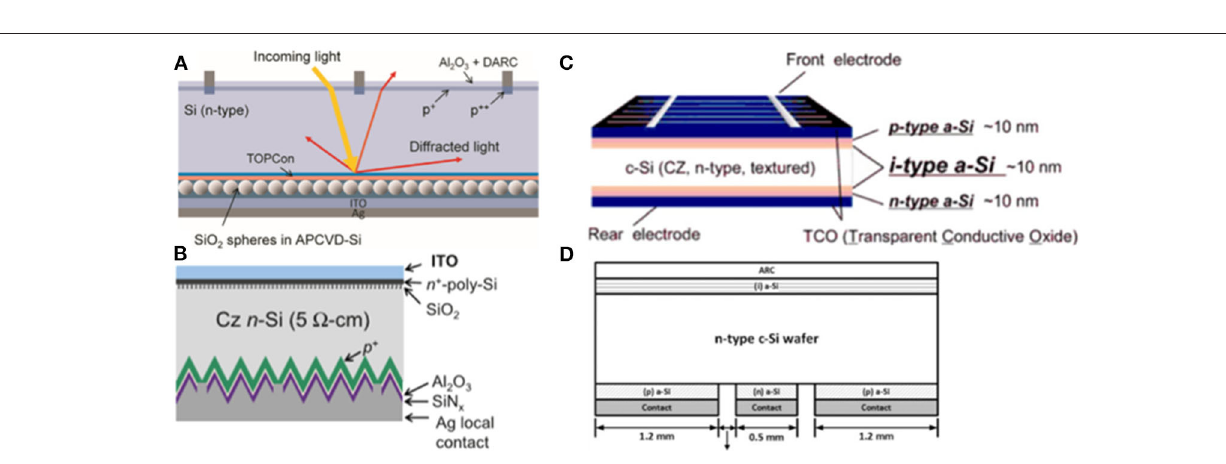
(2019) presented p + /n + poly-Si as tunneling junction enabling low contact resistance and high V OC